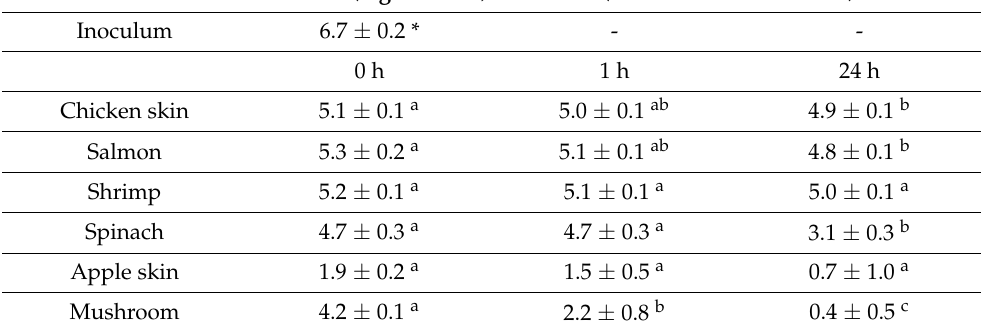
Table 2. HSV-1 Recovery from Foods. Virus Concentrations (log PFU/mL) over Time (Hours